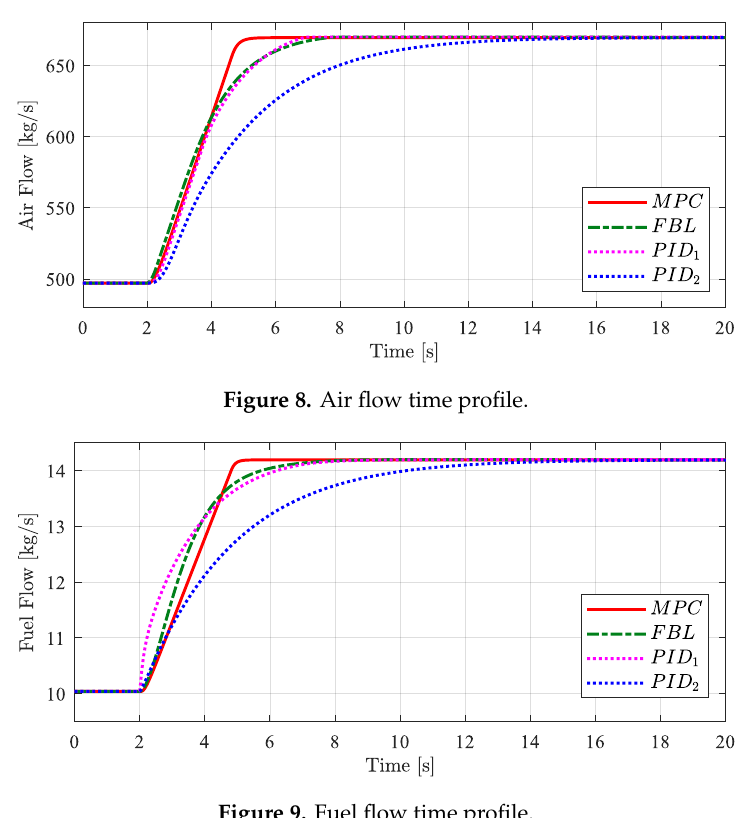
Figure 9. Fuel flow time profile.